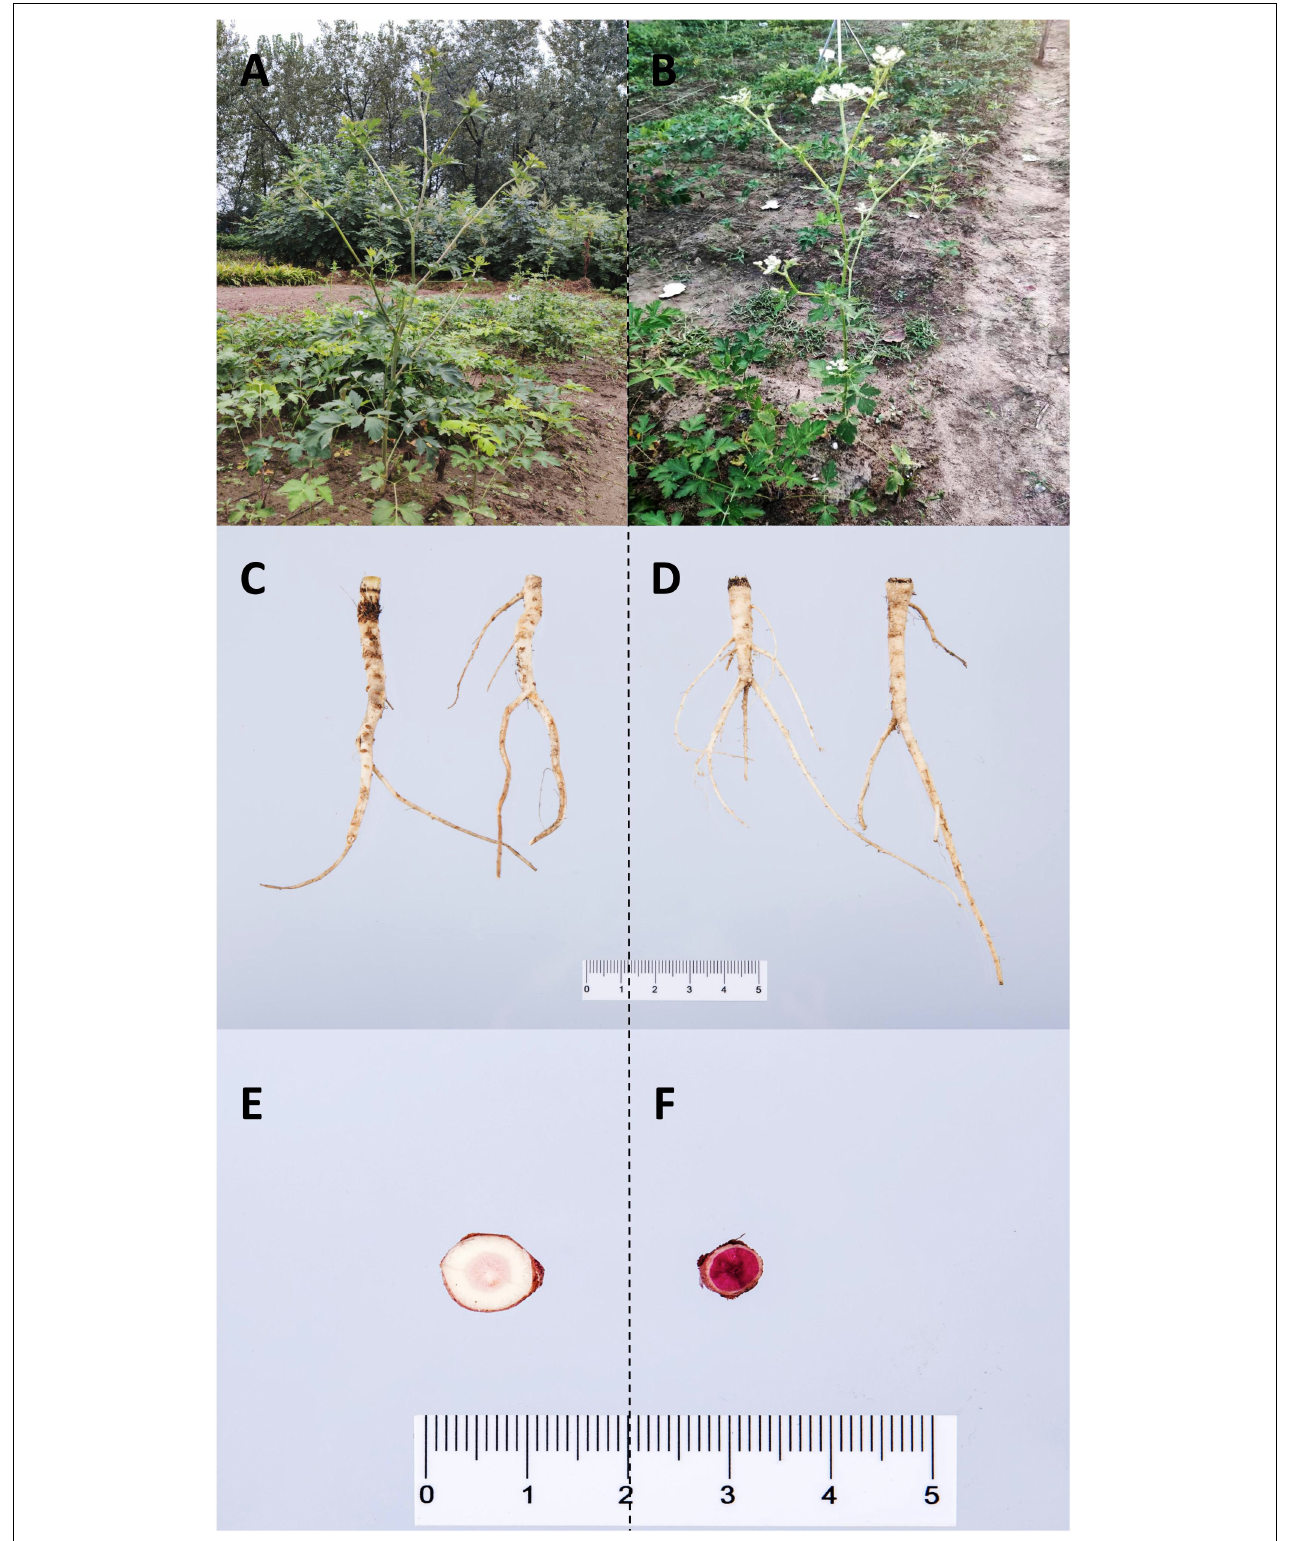
FIGURE 1 | Sample collection and the phloroglucinol staining of unbolted and bolted P. praeruptorum roots. (A) Unbolted P. praeruptorum , (B) Bolted P. praeruptorum , (C) The root of unbolted P. praeruptorum, (D) The root of bolted P. praeruptorum, (E) Phloroglucinol staining of the cross section of the unbolted taproot, (F) Phloroglucinol staining of the cross section of the bolted taproot.